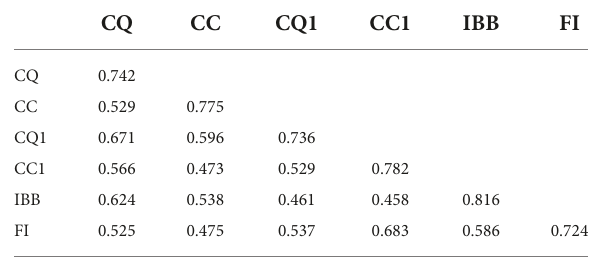
TABLE 4 Validity test of the